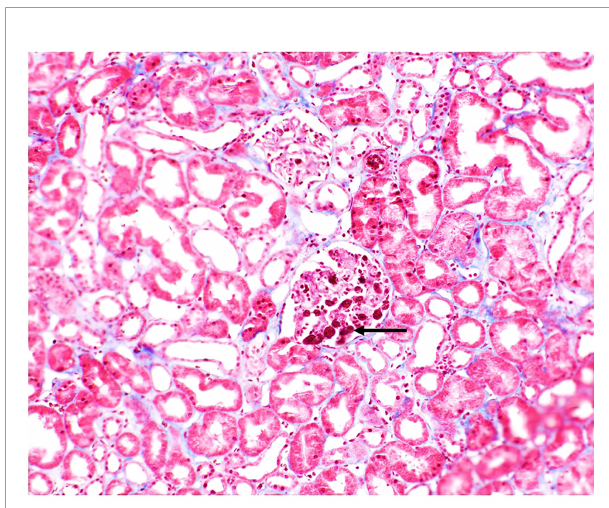
FIGURE 2 | Biopsy image from patient. Fibrin thrombi seen in glomeruli (black arrow). Small arteries and arterioles demonstrated focal fi brinoid necrosis of the arterial wall (not shown).